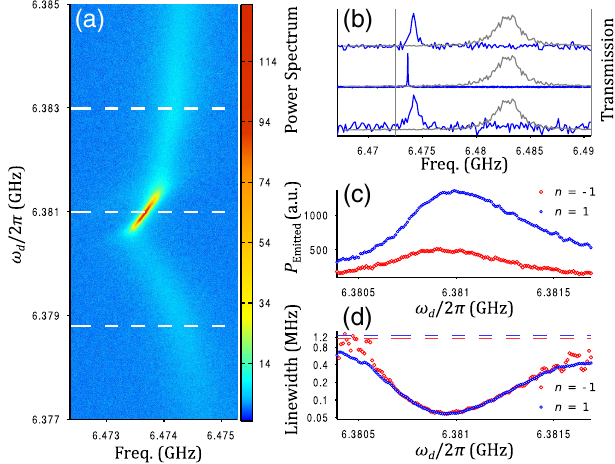
FIG. 4. Ultranarrowing of fluorescence. (a) Power spectrum = 2 π ), at fixed drive ( n ¼ 1 ) for varying drive frequency ( ω d power, reveals linewidth narrowing. Minimum linewidth 65 kHz − ω Þ = 2 π ¼ 2 MHz. (b) Normalized spectra corresponds to ð ω 68 d along dashed lines in (a) are plotted in blue and vertically displaced. For comparison, low power transmission is plotted in solid gray lines and the bare mode frequency is denoted with a vertical gray line. (c) Emitted power (over approximately 3-MHz = 2 π shows simultaneous brightening of n ¼ (cid:3) 1 bandwidth) vs ω d = 2 π . Linewidths vary modes. (d) Fluorescence linewidths vs ω d concurrently for n ¼ (cid:3) 1 and are inversely proportional to emitted power. For comparison, dashed lines show κ = 2 π